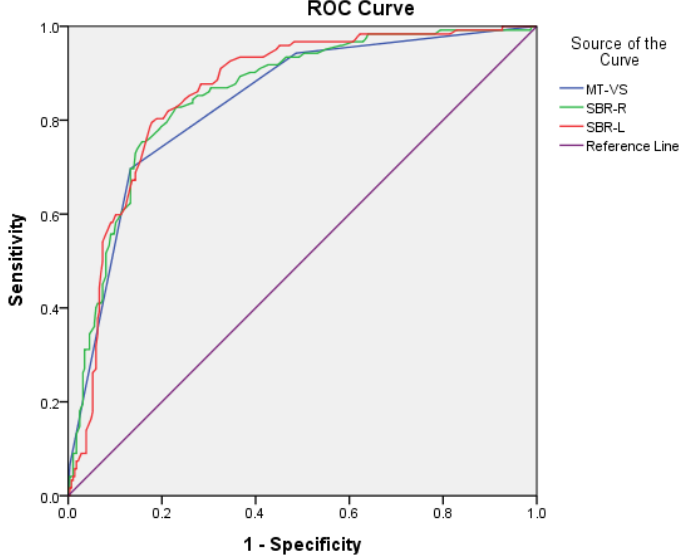
Figure 1. Comparison of area under the curve (AUC), sensitivity, and specificity for MT-VS, SBR-R, and SBR-L between PD and NC groups.